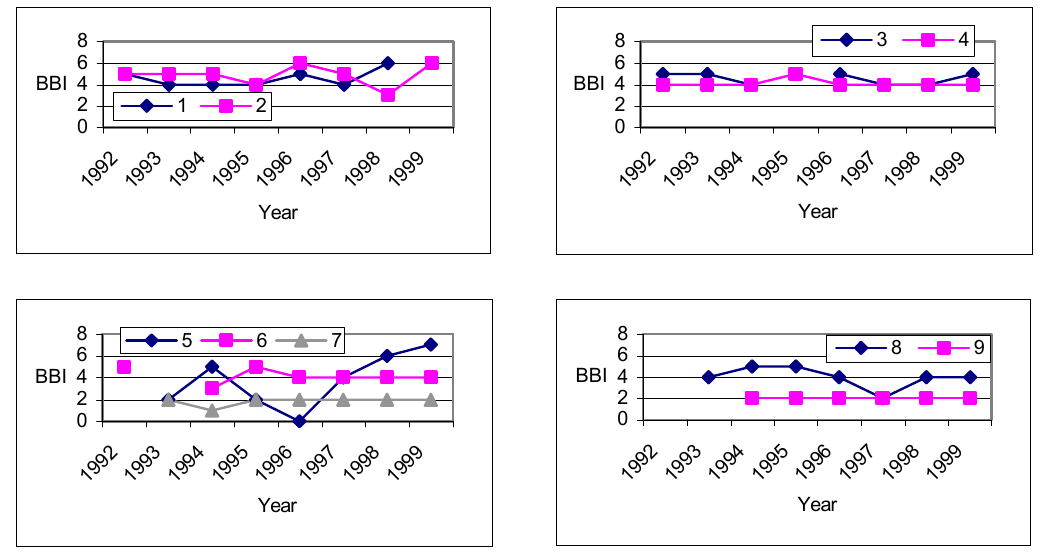
FIGURE 4. Evolution of the BBI in a selection of sampling sites of the VMM in the Dender basin (1 to 9).